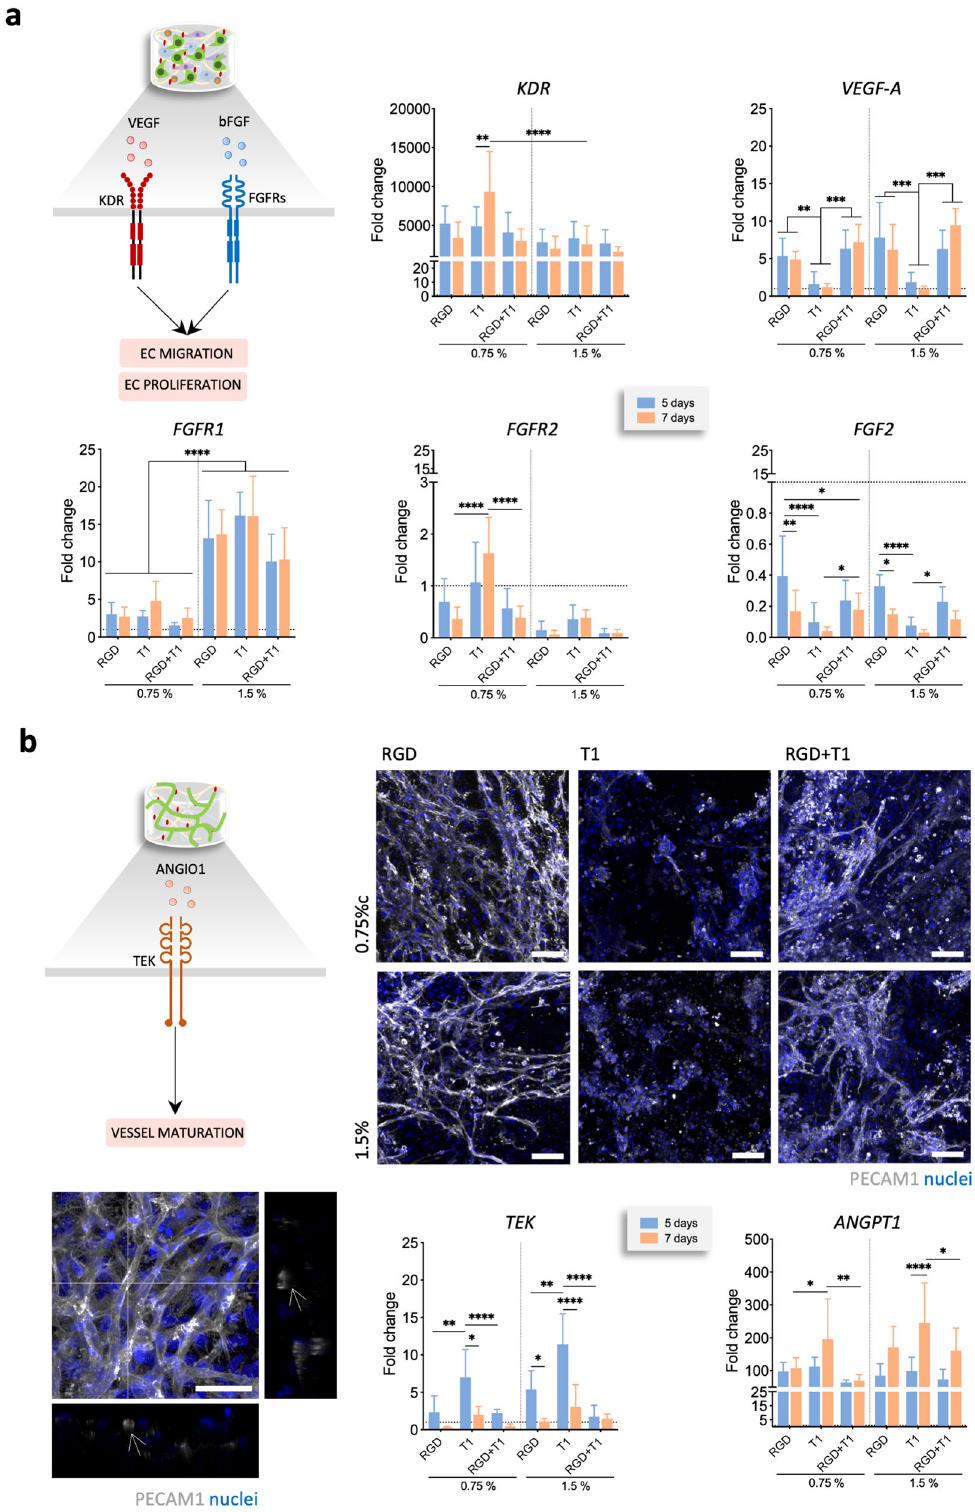
antibody against α v β 3 over the course of a 7-day culture period in RGD-containing spongy-like hydrogels (Fig. 3b). An inhibition of capillary-like structure formation similar to what was observed when SVF cells were pre-incubated with RGD was seen when the blocking antibody was also incubated with cells prior to